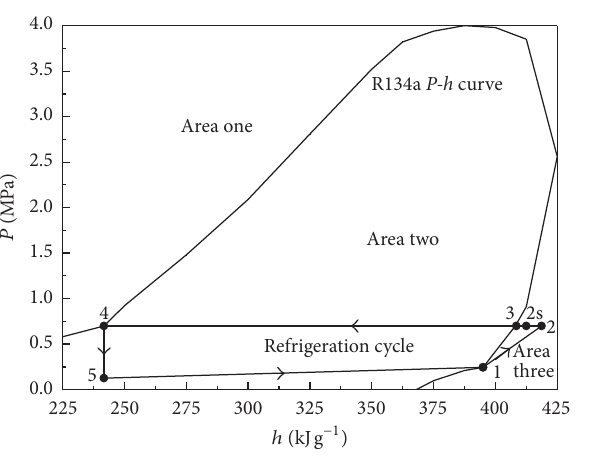
Figure 3: R134a thermodynamic